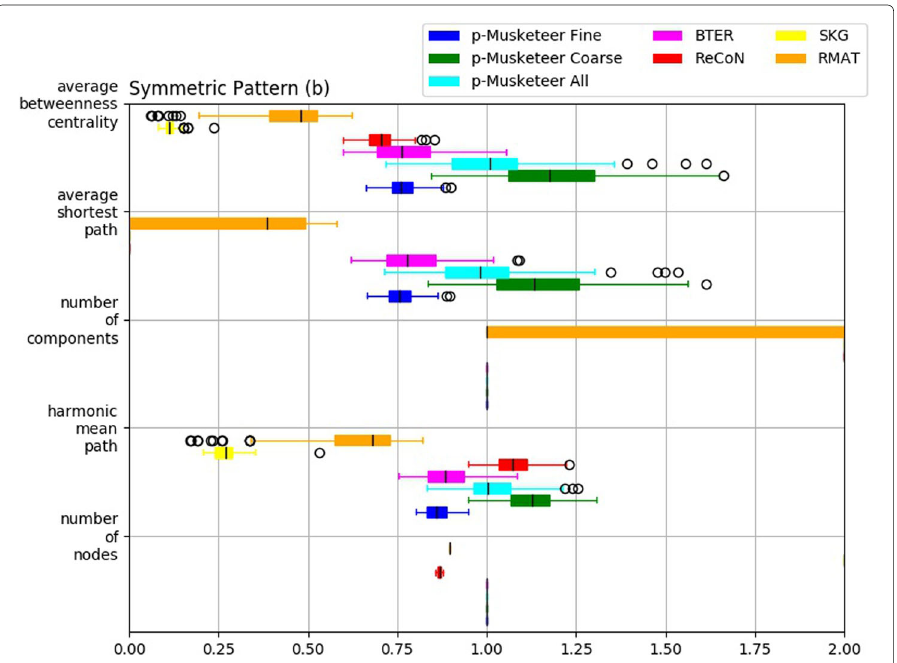
Fig. 11 Computational results on performance of planar Musketeer on symmetric pattern with 1141 nodes and 3162 edges for number of nodes, harmonic mean path, number of components, average shortest path and average betweenness centrality